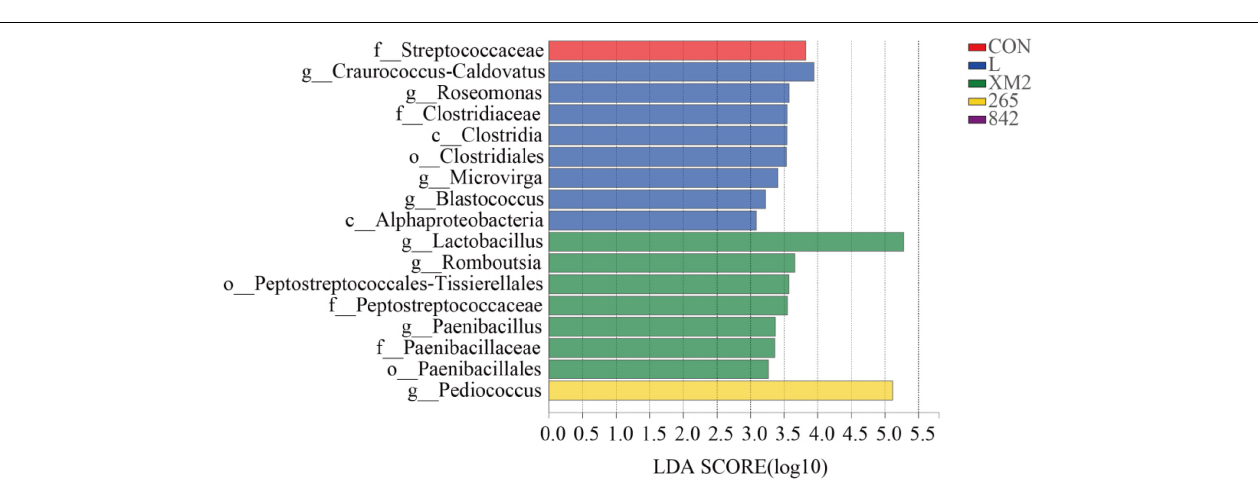
FIGURE 2 | The bacterial community of FM and native grass on 30 days of ensiling. (A) The bacterial community was shown at the phylum level. (B) The extended error bar plot displaying the significant differences among groups at the phylum level (C) . The bacterial community was shown at the genus level. (D) The extended error bar plot displaying significant differences among groups at the genus level. *Shows that the significant difference was at p < 0.05 level. FM, fresh native grass; CON, control group; L, commercial inoculant group; XM2, strain XM2 group; 265, strain 265 group; 842, strain 842 group.